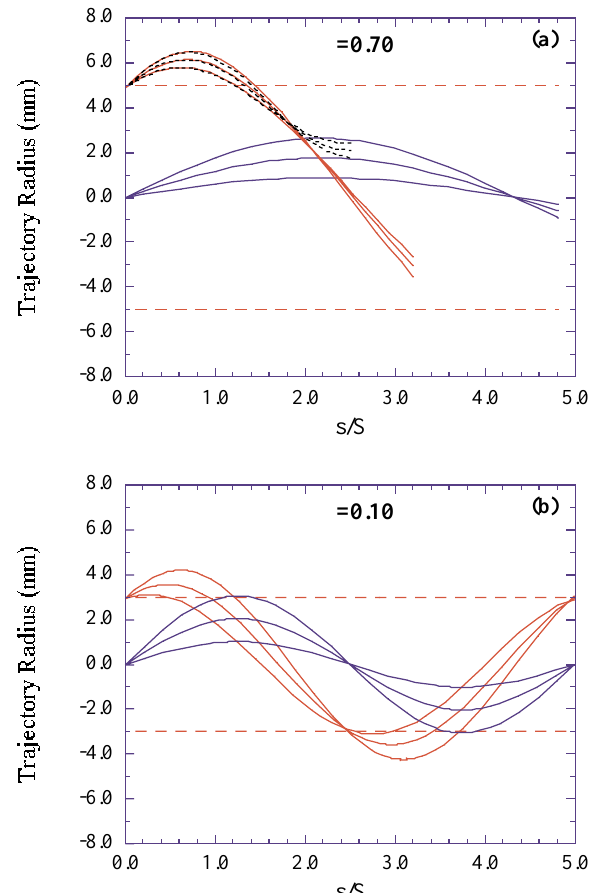
FIG. 7. (Color) Examples of edge and core imaging in a uniform focusing channel for (a) space-charge dominated transport, x (cid:1) 0.7 , a (cid:1) 5 mm, and (b) emittance-dominated transport, x (cid:1) 0.1 , a (cid:1) 3 mm. The channel is the smooth approximation of a lattice with full lattice period S (cid:1) 0.32 m, and s 0 (cid:1) 76 ± . The solid lines correspond to PCM calculations [Eqs. (1) and (2)] while the dotted curves in (a) are plots of Eq. (8). The horizontal broken lines in both (a) and (b) represent the beam